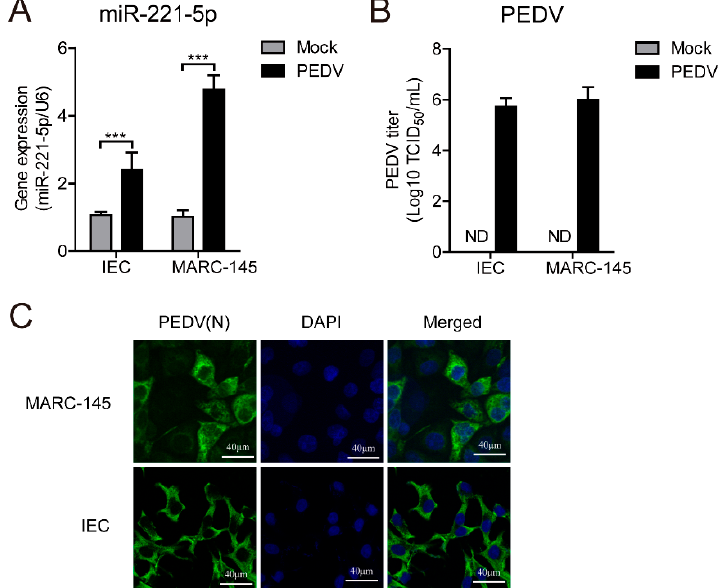
Figure 1. Viral titer of porcine epidemic diarrhea virus (PEDV)-infected cells. ( A ) Real-time qRT-PCR analysis of miR-221-5p expression at 24 h post-infection. Data were normalized to U6 expression. ( B ) Intestinal epithelial cells (IECs) were infected with PEDV CV777, and MARC-145 cells were infected with CH/HBTS/2017 at a multiplicity of infection (MOI) of 1. After 24 h, we determined the tissue culture infectious dose (TCID 50 ) value associated with the viral titer. ( C ) Immunofluorescence analysis of intracellular PEDV N protein levels at 24 h post-infection. Cells were fixed and stained with DAPI (blue), with green representing PEDV N protein staining. Scale bar = 40 µ m. Comparisons between groups were determined by Student’s t test. *** p < 0.001.